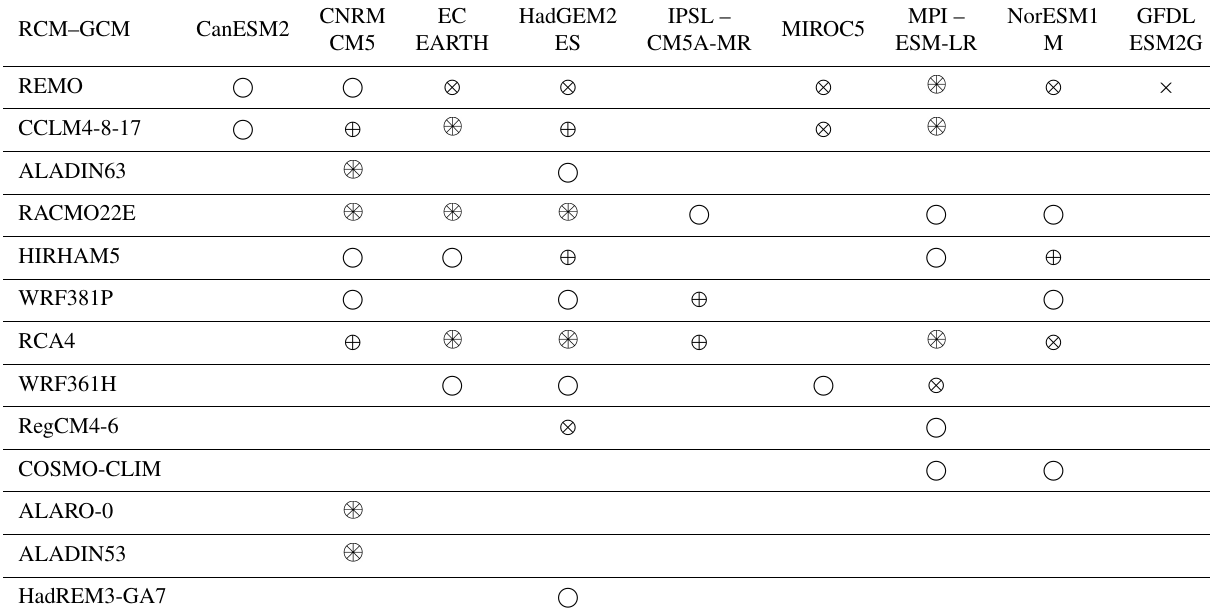
Table 1. Combination of available GCM and RCM pairs with the scenarios RCP2.6 ( × ), RCP4.5 ( + ), and RCP8.5 ( (cid:13) ). RCM–GCM CanESM2